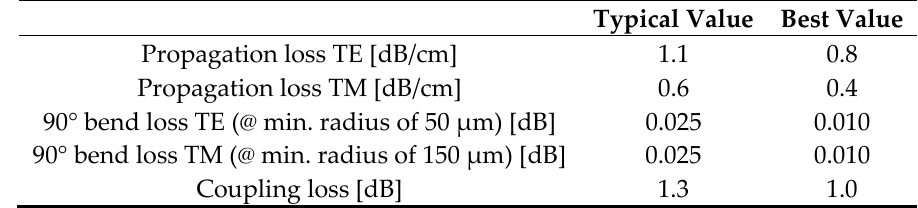
Table 1. Typical and best values for TE/TM propagation-, bend- and coupling losses of SiN waveguides at λ = 850 nm.